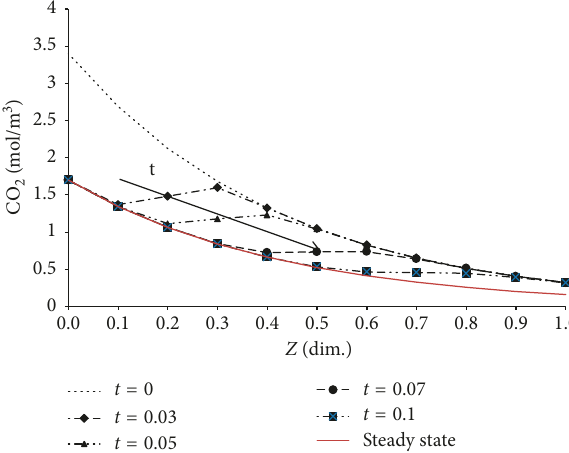
Figure 9: Dynamic change of the CO input concentration.